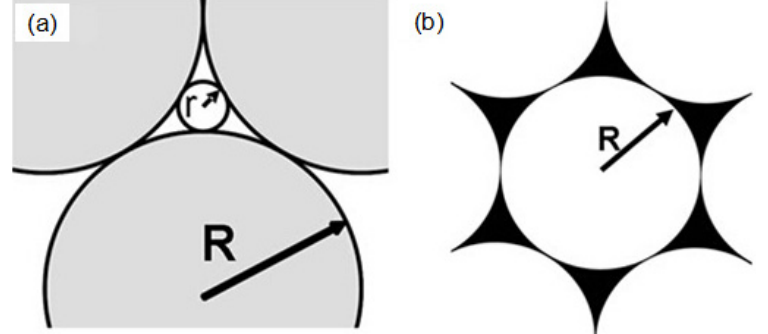
Figure 10. ( a ) Hexagonal close-packed PS nanosphere structure; ( b ) Au-Ag triangle hexagonal nanoparticle arrays after the PS nanosphere masks were removed.